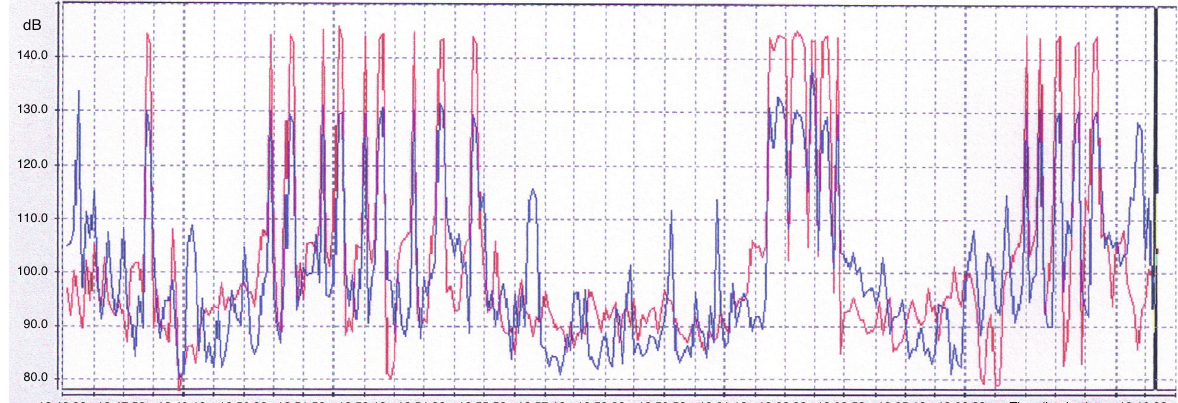
Figure 2 Sound pressure level (peak --- C-weighted) measured in the shooting range as a function of time. Measurement in red with external microphone; in blue, measurement with insertion microphone (MIRE).